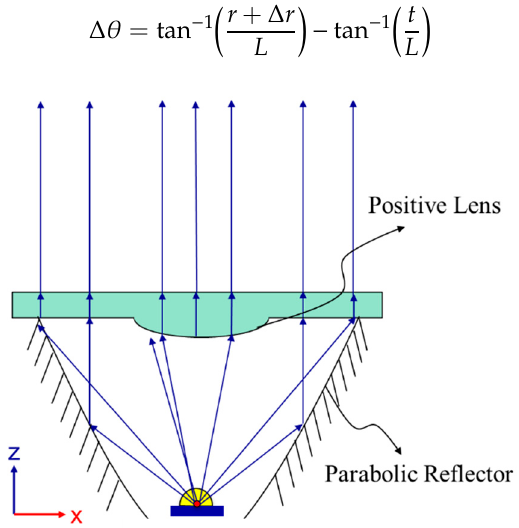
Figure 4. Basic optical structure of the projection light.